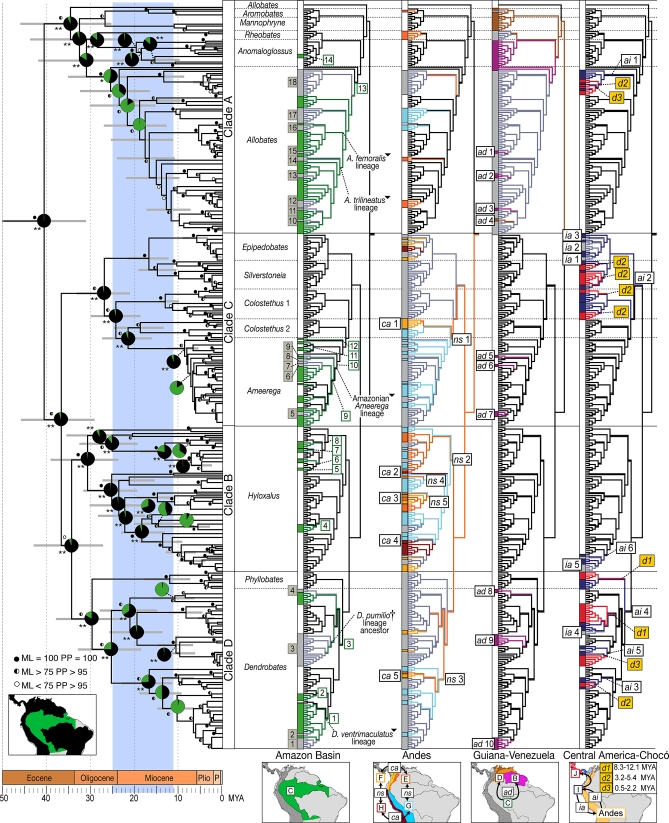
Chronogram and Major Biogeographic Events of the Poison Frogs Divided by Major Regions and Inferred from the DEC AnalysisThe green slice of the pie charts is the proportion of the likelihood associated with Amazonian reconstruction using Bayesian analysis of ancestral traits. The test results against the null hypothesis of an Amazonian ancestral state are indicated as *, p < 0.05, significant, and **, p < 0.001, highly significant. In the chronogram, support values from 200 nonparametric bootstrap replicates (ML), Bayesian posterior probabilities (PP), and the 95% CI of the estimated node age are also indicated. The major geographical events reconstructed using the SM2 model were mapped onto the ML phylogeny. The Amazon Basin subtree includes dispersals into Amazonia (numbered white squares), out of Amazonia (numbered gray squares), major lineage diversifications (5), and a lineage extinction (†). The Andes subtree includes cross-Andean (ca boxes) events, Northern-Southern Andean (ns boxes) dispersals, and the identification number of each event (see Table S12). The Guiana-Venezuela subtree includes dispersals toward this region from the Amazon Basin lineages (ad boxes) and the identification number of each event (see Table S12). The Central America-Chocó subtree indicates the three dispersals from Chocó and Central America (d1, d2, and d3 yellow boxes), dispersals from the Andes to the Chocó (ai boxes), from the Chocó to the Andes (ia boxes) and the identification number of each event (see Table S12). For all subtrees, the tree branches and the rectangles at the tips of each tree are color coded as follows: (1) gray rectangles connected by gray branches mean extant lineages distributed in other areas different from the subtree region, but that descend from an ancestor distributed in the exemplified subtree region; (2) white rectangles connected by black branches indicate extant lineages distributed in other areas different from the subtree region; (3) color-coded rectangle and branches indicate extant lineages distributed in the exemplified subtree region. The duration of the Miocene floodbasin systems is indicated by blue-gray area. For detailed ancestral area reconstructions and date estimates with confidence intervals see Table S8.